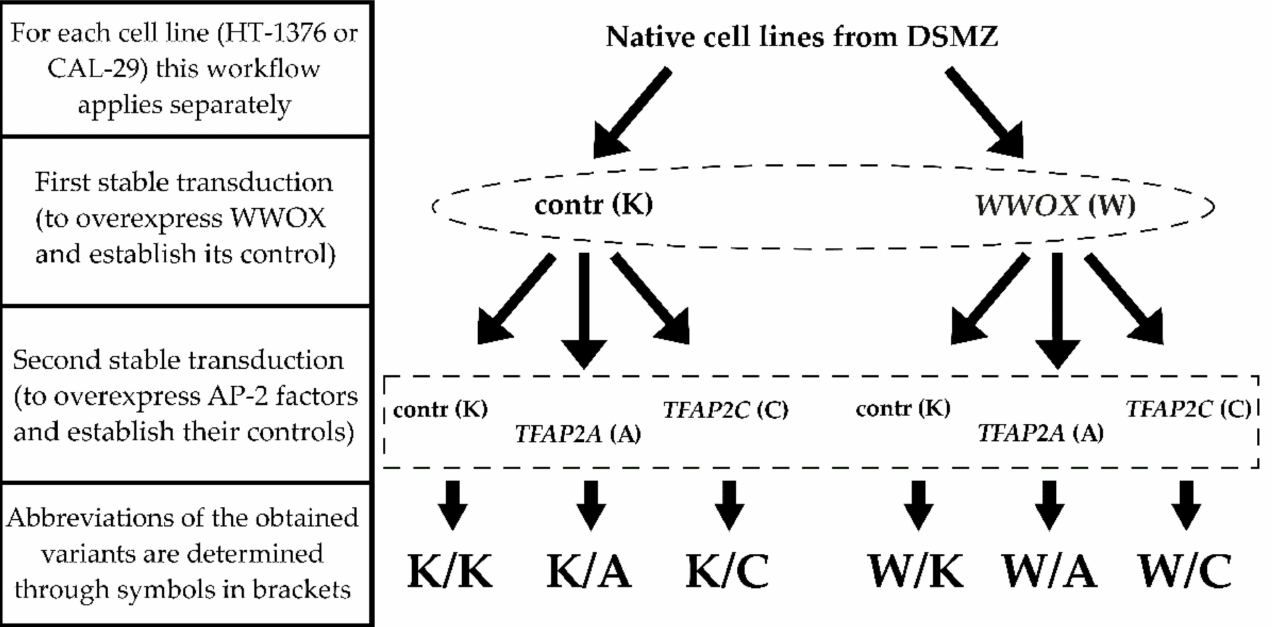
Figure 1. Stable transductions scheme for both HT-1376 and CAL-29 cell